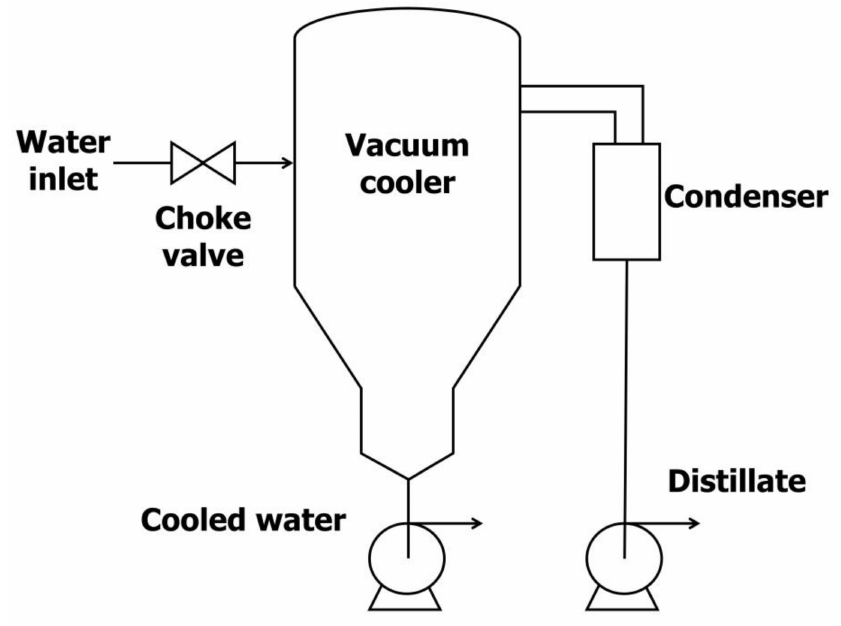
Figure 2. Scheme of the vacuum cooler, adapted from